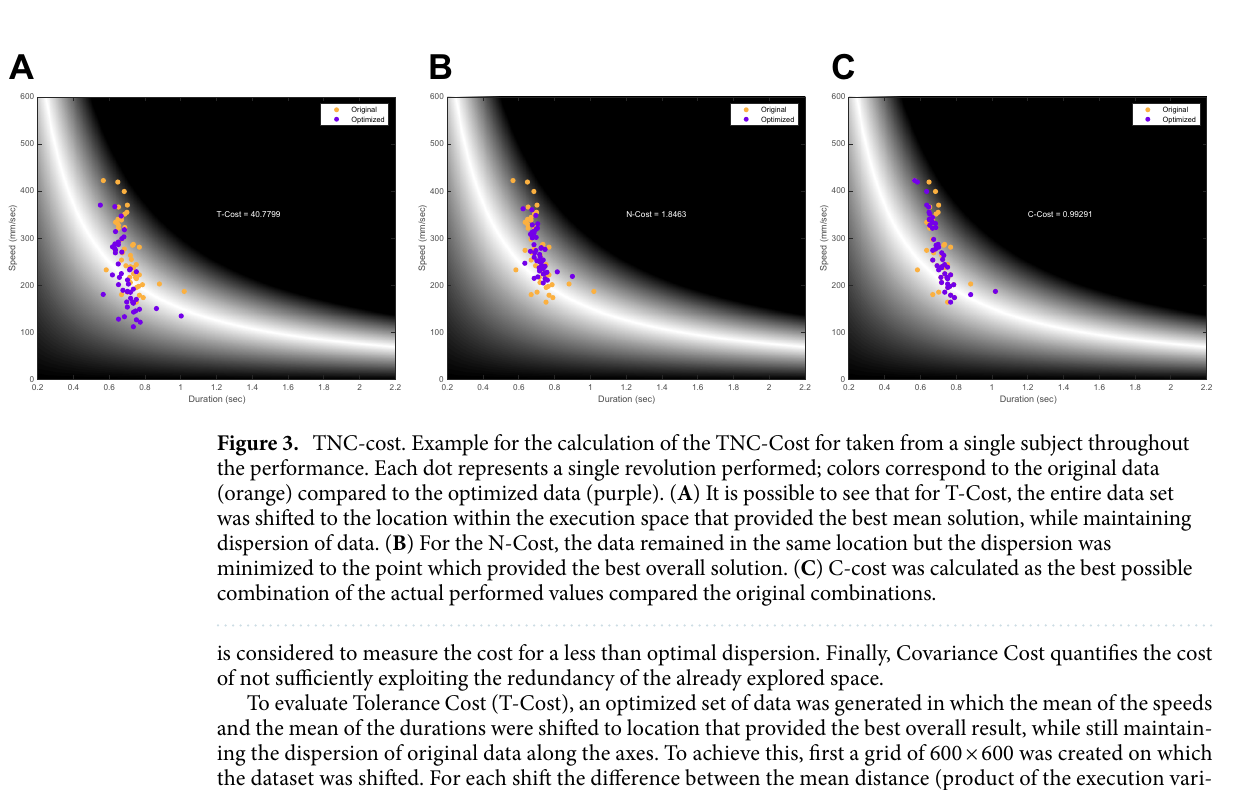
Figure 2. Execution space. Within the possible combination of the execution variables (duration and speed), the most congruent combinations with the target distance create the solution manifold (represented in white). The better the combination of the variables is (i.e., the closer their combination yields the target distance) the whiter the area is.